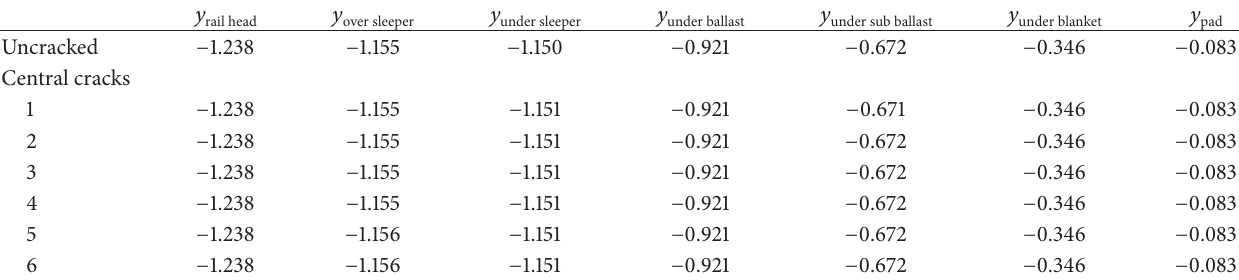
Table 6: Deflections (mm) in the track model with 1 to 6 central cracks.